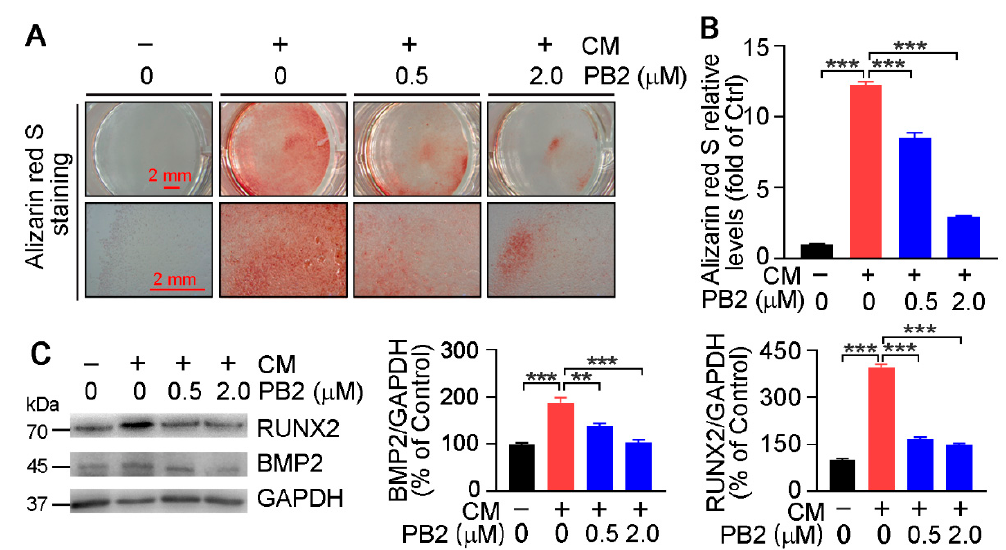
Figure 4. Procyanidin B2 inhibits calcification in vitro. HASMCs were cultured in a normal medium, calcification medium (CM, 3 mM Na 2 HPO 4 /NaH 2 PO 4 (1:2)), or CM plus PB2 at the indicated concentrations for 2 weeks. ( A ) Calcium deposition was determined by alizarin red S staining, and they images were photographed by the microscope. ( B ) The cells were then added to 10% acetic acid to extract the stained alizarin red S dye. The extraction solution was used to determine absorbance at the 405 nm wavelength with a spectrophotometry. Ctrl, HASMCs were cultured in a normal medium without PB2 treatment. *** p < 0.001 ( n = 3). ( C ) HASMCs were cultured in a normal medium, CM, or CM plus PB2 treatment at the indicated concentrations for 1 week. The protein expression of RUNX2 and BMP2 was determined by Western blot with the quantitative analysis of the band density. ** p < 0.01, *** p < 0.001 ( n = 3).